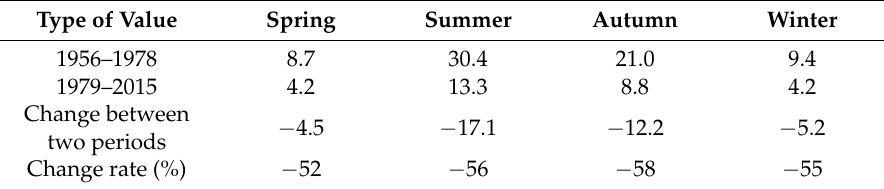
Table 6. Variations in seasonal R between the two